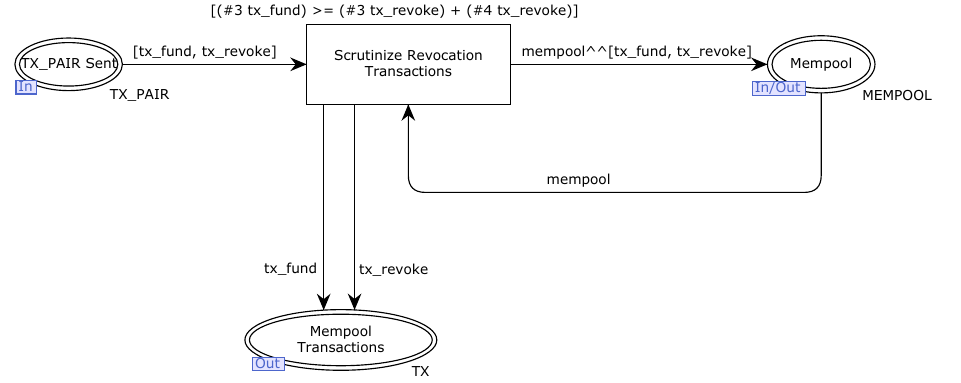
Figure 14. ‘Add Unconfirmed Revocation Transactions to Mempool’ sub-module of the BlockVoke CPN